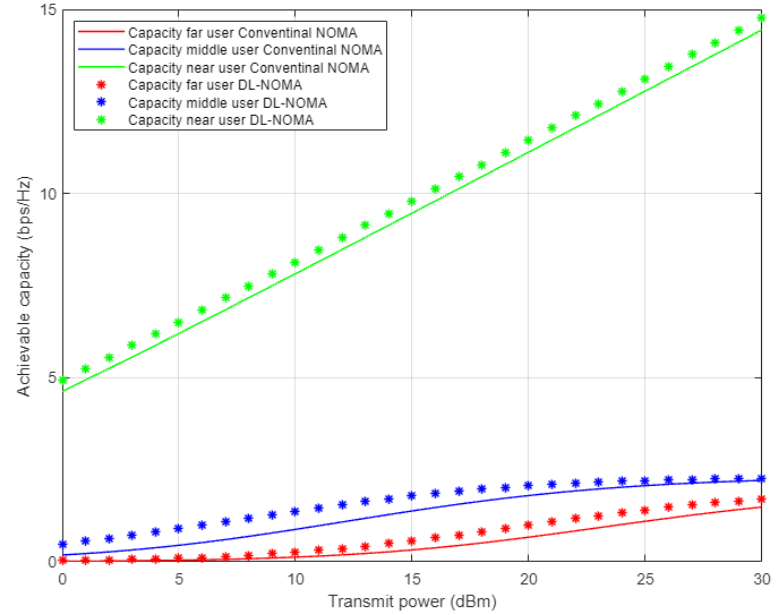
Figure 7. Individual capacity vs. power-for proposed DL-NOMA and conventional NOMA (Rayleigh Channel).